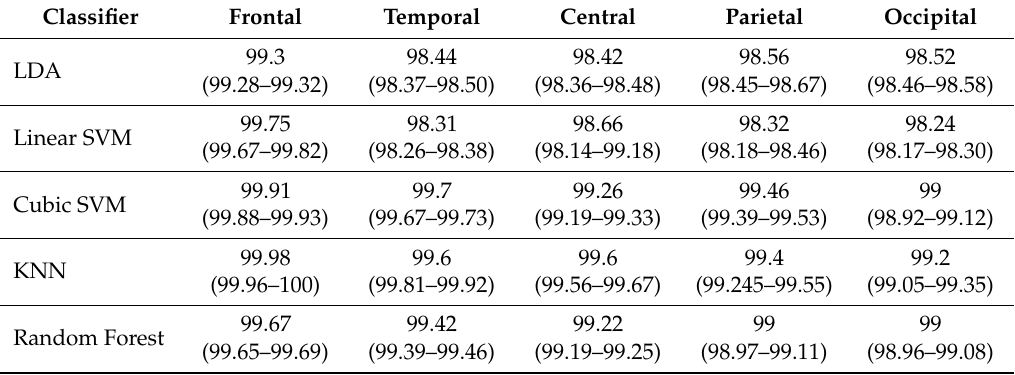
Table 5. Accuracy (95% CI) for detecting stress and non-stress from di ff erent electrode